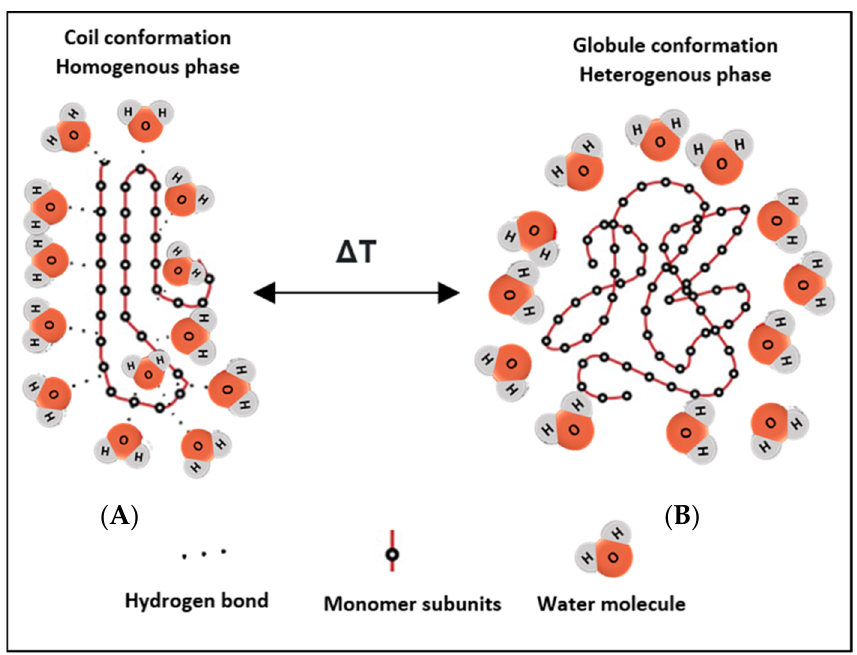
Figure 1. Schematic depicting the reversible phase transition from coil-to-globule and vice versa upon heating/cooling. ( A ) shows the hydrated state of the polymer, where hydrogen bonds are formed with surrounding water molecules at the hydrophilic ends, while ( B ) shows the nonhomogeneous state, where the chains dehydrate into globules and fold up, forming a water-rich and a polymer-rich phase. The change in conformation results from a change in the temperature of the system.